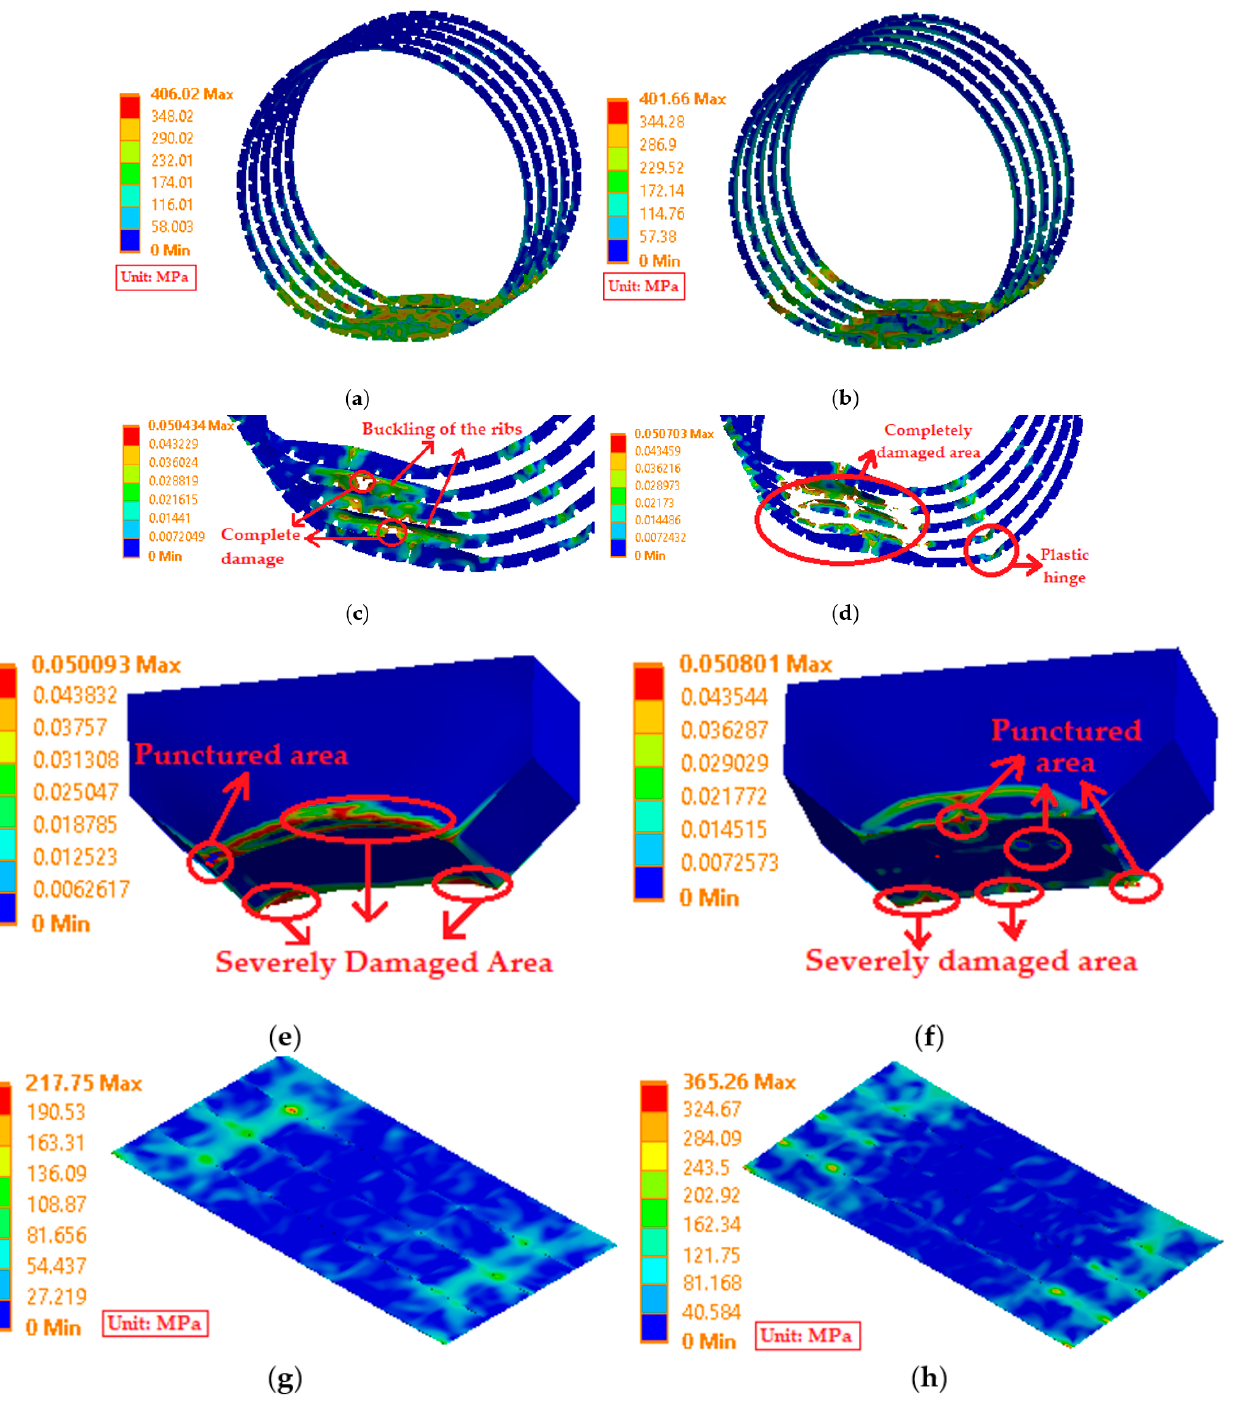
Figure 5. Maximum equivalent stress and damage configuration: ( a ) Maximum equivalent stress of reinforced airframe at 0.015 s; ( b ) Maximum equivalent stress of traditional airframe section at 0.015 s, ( c ) Effective plastic strain of reinforced airframe, ( d ) Effective plastic strain of traditional